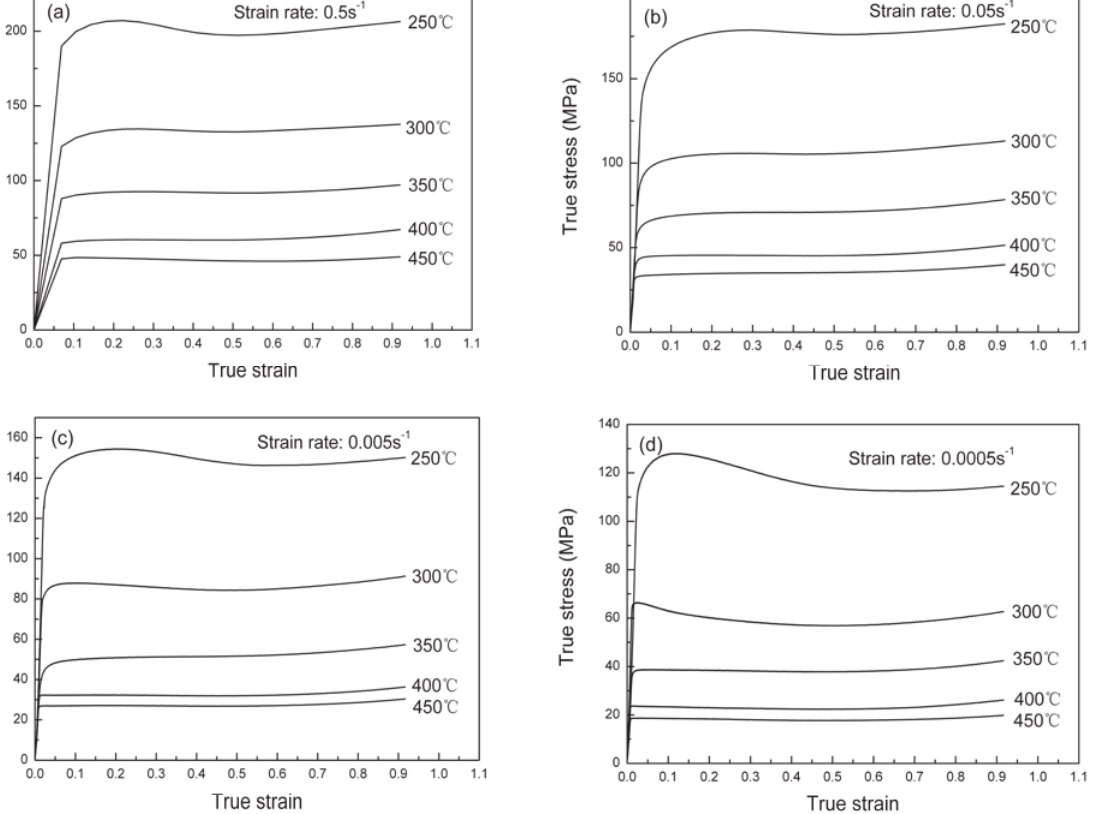
Fig. 3: True stress-true strain curves of 7005 alloy under strain rates of (a) 0.5 s − 1 ; (b) 0.05 s − 1 ; (c) 0.005 s − 1 ; (d) 0.0005 s − 1